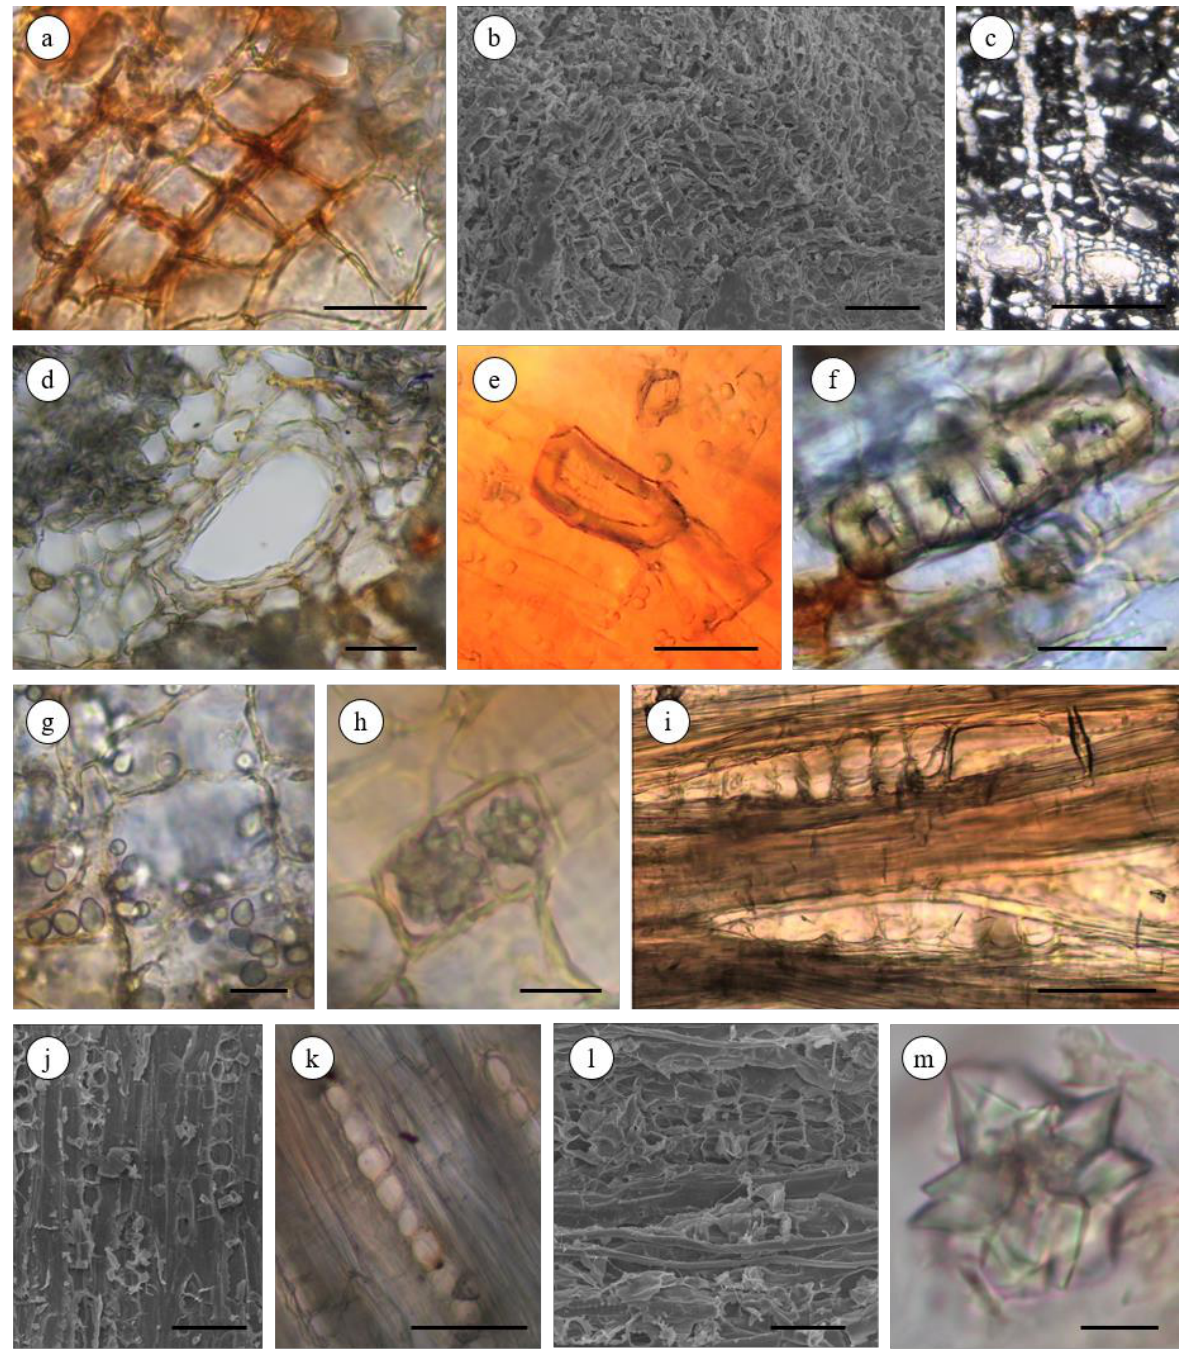
Figure 3. Light and scanning electron microscopy photographs of A. occidentale stem bark ( a , c – h ) and scanning electron microscopy ( b ) photographs of transverse sections of AoB; ( a , b ) flattened and reddish-brown phellem cells, with slightly thickened walls; ( c ) phelloderm cell tissue and cortical parenchyma with secretory channels; ( d ) secretory channel; ( e ) thin-walled sclereids. ( f ) Group of thick-walled sclereids; ( g ) starch granules; ( h ) idioblast containing calcium oxalate crystal clusters. Light microscopy ( i , k , m ) and scanning electron microscopy ( j , l ) photographs of longitudinal sections of AoB; ( i – k ) uni-, bi-, tri- and tetra-seriate medullary rays; ( k , l ) sieve tubes, phloem parenchyma, and phloem fibers. ( m ) Light microscopy photograph of an isolated druse of calcium oxalate. Scale bar: ( a , c – f ) = 50 µm; ( g , h ) = 20 µm; ( b , i – l ) = 100 µm; ( m ) = 10 µm.